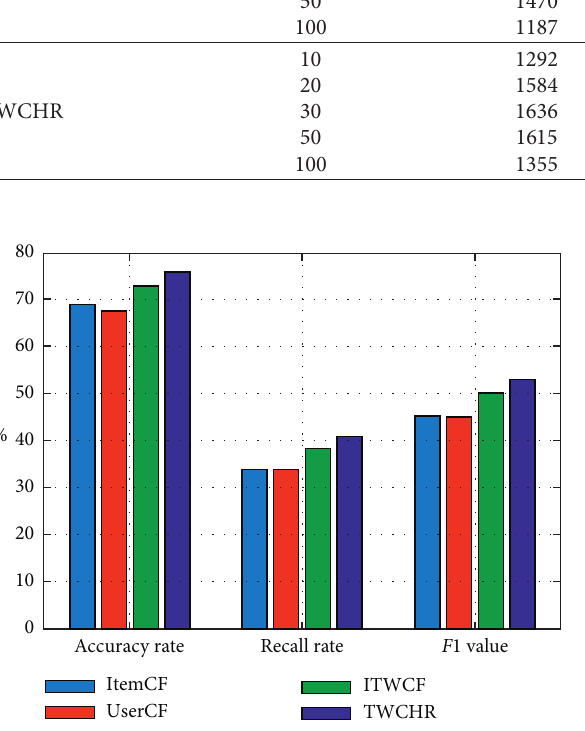
Figure 5: Performance comparison of four